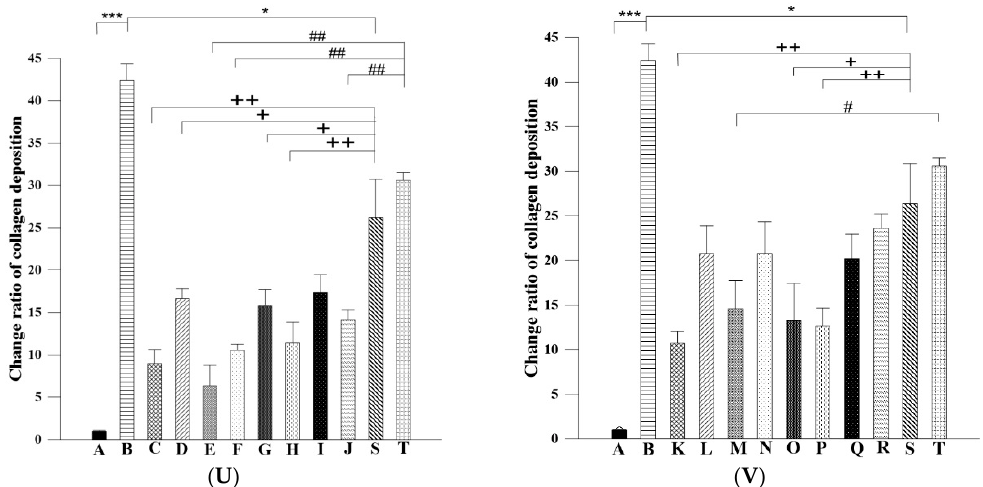
Figure 7. ( A – T ) Masson’s Trichrome staining of the liver sections in the experimental mice that received alcohol through two modes. The observations were performed at 200× magnification (the image on bottom left site was 100× magnification). Group A showed normal mice liver as Group B represented the mice received 3-week 30% alcohol feeding. Mice were given Asta-lipo or pure liposomes for 2 or 4 weeks prior to the 3-week 30% alcohol consumption (Groups C – F and K – N ) or 3-week 30% alcohol administration plus a second dose of 30% alcohol (Groups G – J and O – R ) as shown in Table 1. ( U and V ). Mice were treated with Asta-lipo (subfigure U ) or pure liposomes (subfigure V ) for 2 and 4 weeks and the collagen content in liver of each group was semi-quantitated by ImageJ software (Version 1.50, National Institutes of Health, USA). The color settings in ImageJ software was maintained at all times between the calculations of the blue-stained areas in samples. Magnification 100× was employed to evaluate the samples and the calculation was repeated in four microscopic fields. The measurement was repeated in four microscopic fields. (Group A and the treated groups were compared to Group B ; Groups which received 2-week p.o and i.p. administration with Asta-lipo or pure liposomes were compared to Group S; Groups which received 4-week p.o and i.p. administration with Asta-lipo or pure liposomes were compared to Group T; N = 4, *,#,+ P < 0.05, ##,++ P < 0.01 and *** P < 0.001, by ANOVA).